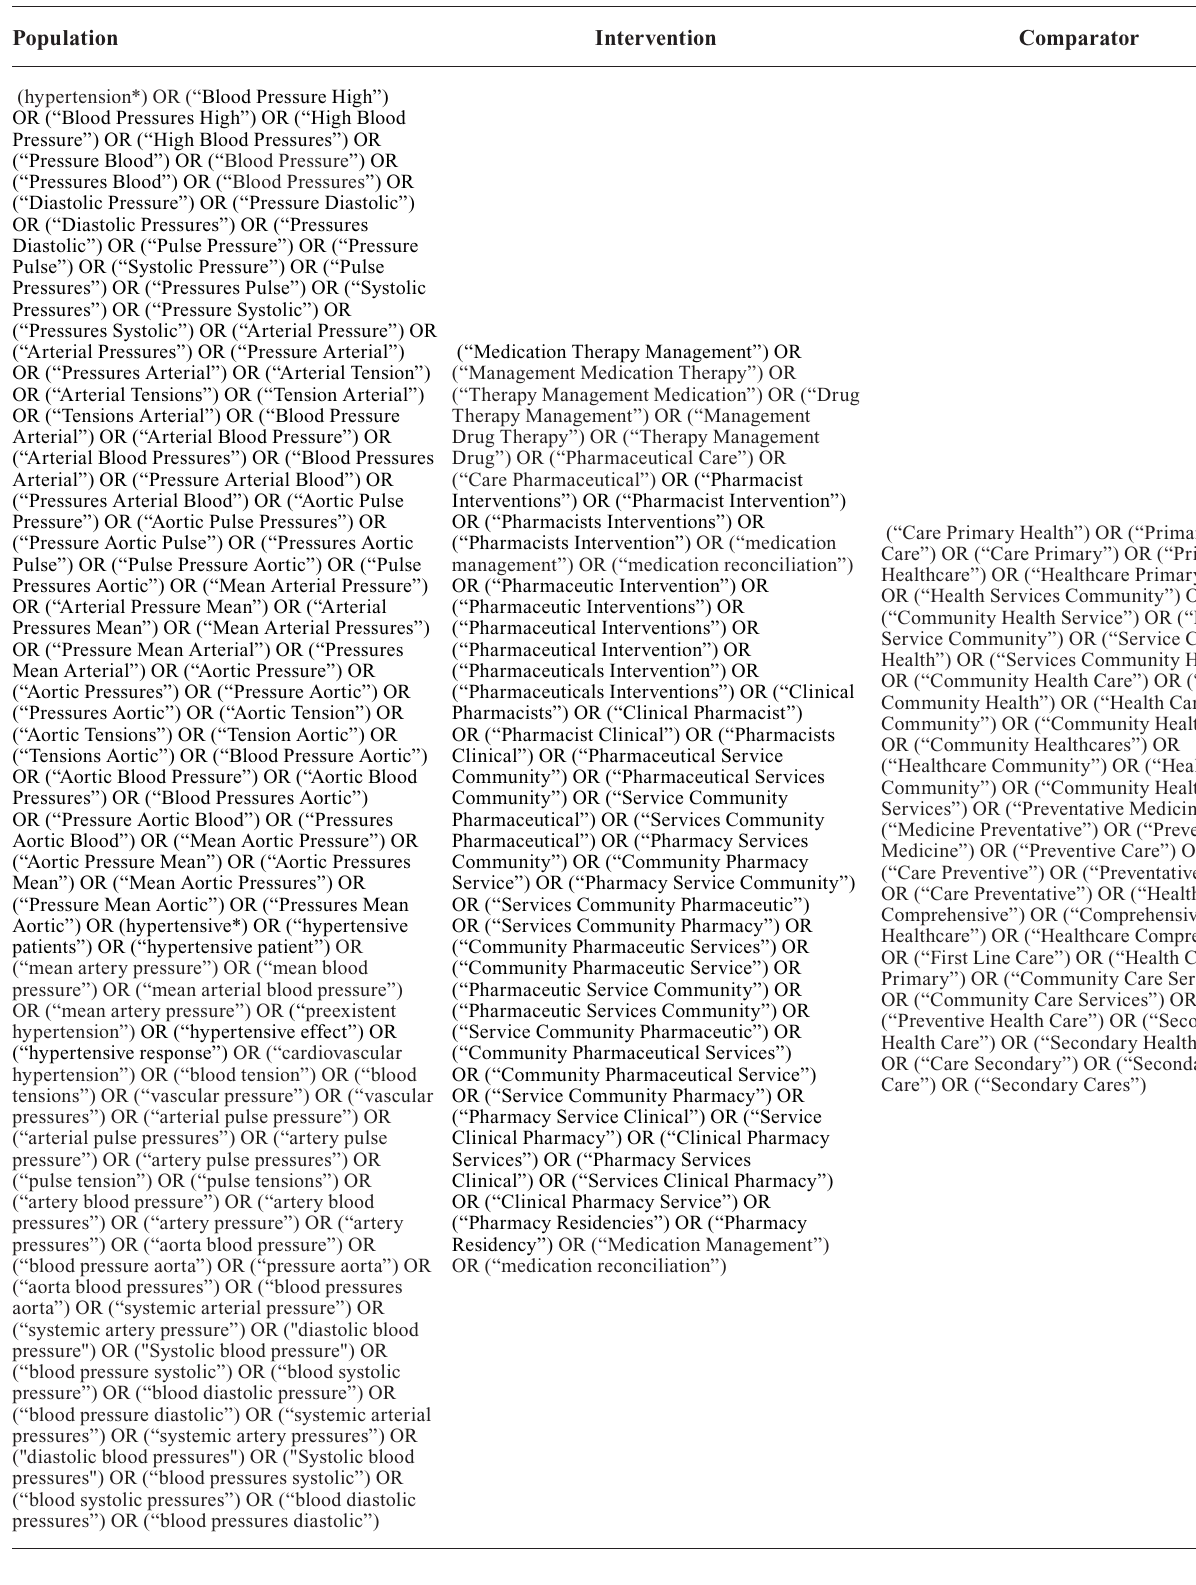
TABLE III - Used words in the search strategy (Entry terms and synonyms)